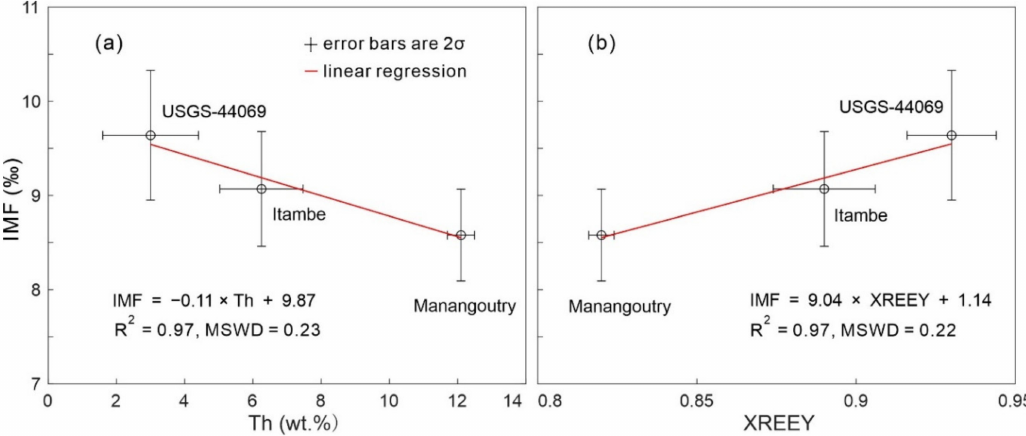
Figure A3. Example of ( a ) IMF-Th and ( b ) IMF-YREEPO 4 (XREEY) curve fitting for